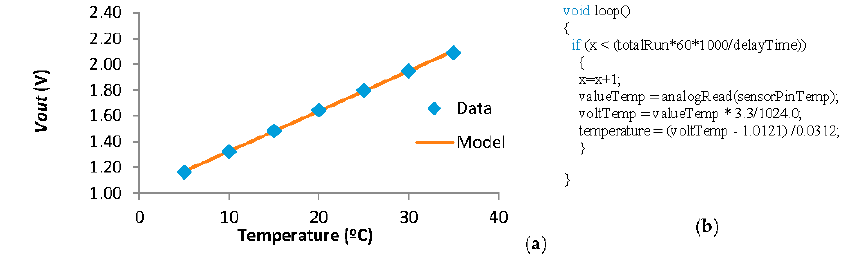
Figure 10. ( a ) Data and ( b ) code of the temperature sensor.